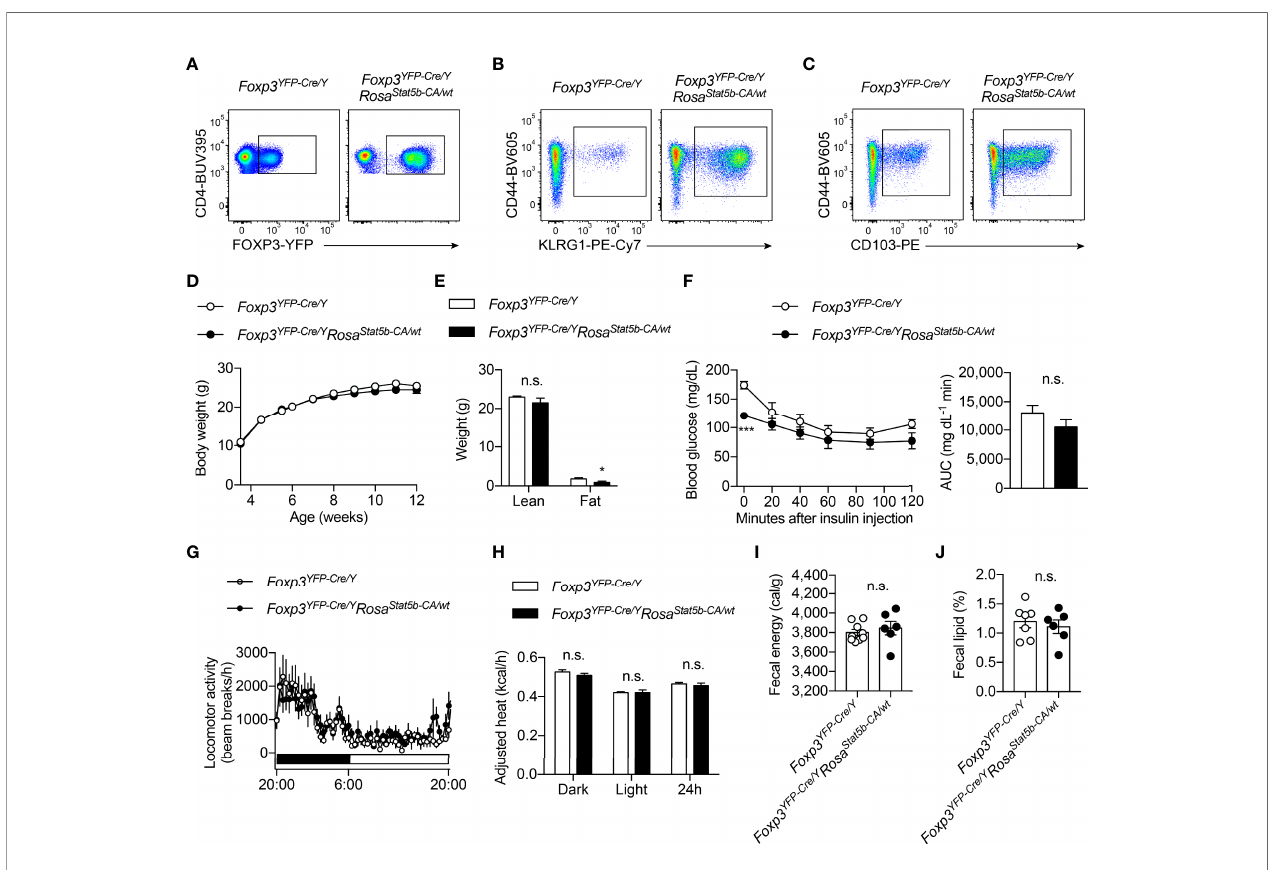
FIGURE 3 | Characterization of Foxp3 YFP-Cre/Y Rosa26 Stat5b-CA/wt mice. (A – C) Flow cytometric quanti fi cation of FOXP3-YFP + CD4 + Treg cells (A) , CD44 + KLRG1 + (B) and CD44 + CD103 + (C) effector Treg cells in lymph nodes from Foxp3 YFP-Cre/Y and Foxp3 YFP-Cre/Y Rosa26 Stat5b-CA/wt mice. (D) Growth curve of Foxp3 YFP-Cre/Y (n = 10) and Foxp3 YFP-Cre/Y Rosa26 Stat5b-CA/wt (n = 9) mice fed with NC. (E) Lean and fat mass of NC-fed Foxp3 YFP-Cre/Y (n = 7) and Foxp3 YFP-Cre/Y Rosa26 Stat5b-CA/wt (n = 6) mice. (F) Insulin tolerance test of NC-fed Foxp3 YFP-Cre/Y (n = 8) and Foxp3 YFP-Cre/Y Rosa26 Stat5b-CA/wt (n = 7) mice. Area under curve (AUC) is shown to the right. (G) Locomotor activity and (H) body weight-adjusted heat production of NC-fed Foxp3 YFP-Cre/Y (n = 7) and Foxp3 YFP-Cre/Y Rosa26 Stat5b-CA/wt (n = 6) mice, determined by metabolic cages. (I) Fecal energy and (J) fecal lipid percentage of NC-fed Foxp3 YFP-Cre/Y (n = 7) and Foxp3 YFP-Cre/Y Rosa26 Stat5b-CA/wt (n = 6) mice. Data are presented as mean ± SEM. n.s., not signi fi cant; *, p < 0.05; ***, p < 0.001 by unpaired student ’ s t-test or two-way ANOVA (D, F)